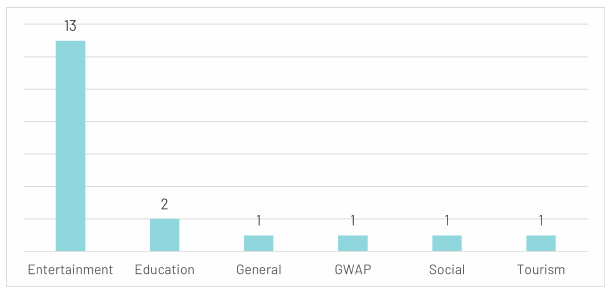
Figure 9. Purposes of games addressed by the